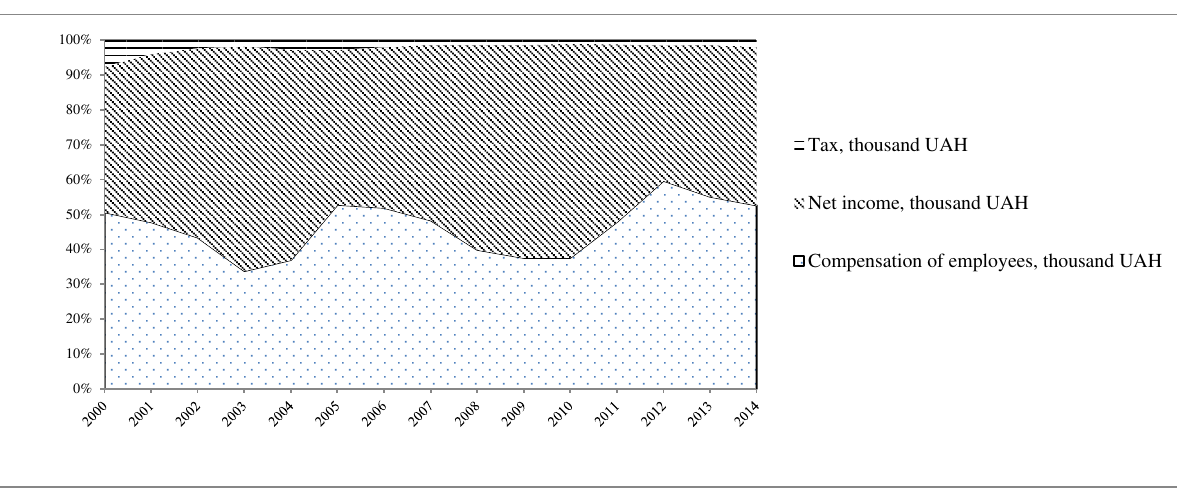
Fig. 4. The value added structure of financial institutions in Ukraine